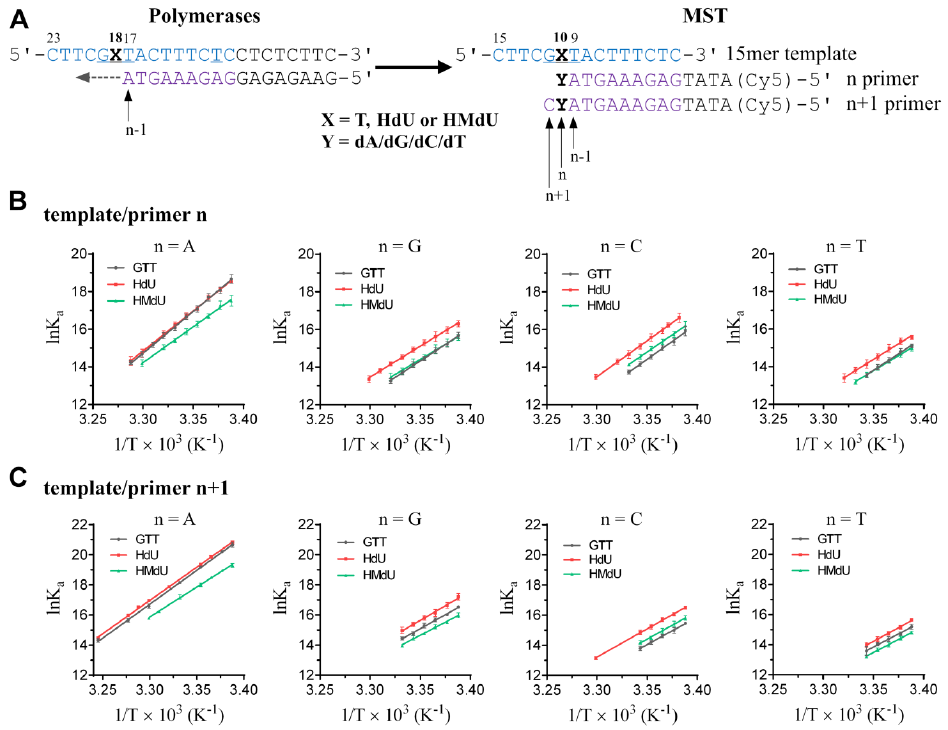
Figure 2. Microscale thermophoresis (MST) determination of the thermodynamic parameters of DNA constructs with nucleotide misincorporation opposite thymine and its derivatives. ( A ) Sets of sequences of successive template-primers designed to simulate translesion DNA synthesis (TLS), where X indicates thymine or its HdU or HMdU variant, and Y is the site of a mismatch. n − 1: position one nucleotide before lesions, n: position opposite the lesions, n + 1: position one nucleotide behind lesions. The identical 15mer template sequence is in blue and complementary primers in violet color. ( B , C ). van’t Ho ff plots of the n or n + 1 primer-template hybridization reactions. K d values were calculated for each temperature by fitting the T-Jump or thermophoresis signal and plotted as ln( K a = 1 / K d ) vs. 1 / T (K). ∆ H was obtained from the slope m of the linear fit as m = − H o / R . Under the assumption that ∆ H is constant in the relatively small linear range of the van’t Ho ff plot, ∆ S was directly derived from the plot as y(0) = ∆ S o / R . The universal gas constant R = 8.314 J K − 1 mol − 1 . Data are means ( ± SD) from at least two di ff erent experiments; coe ffi cient of determination r 2 ≥ 0.99.